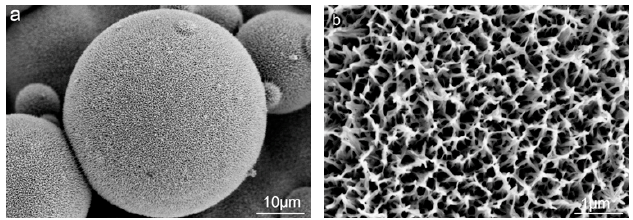
Figure 2. ( a ) SEM image of microstructures after hydrothermal treatment and ( b ) high-resolution images of porous nanostructures on the microstructure.